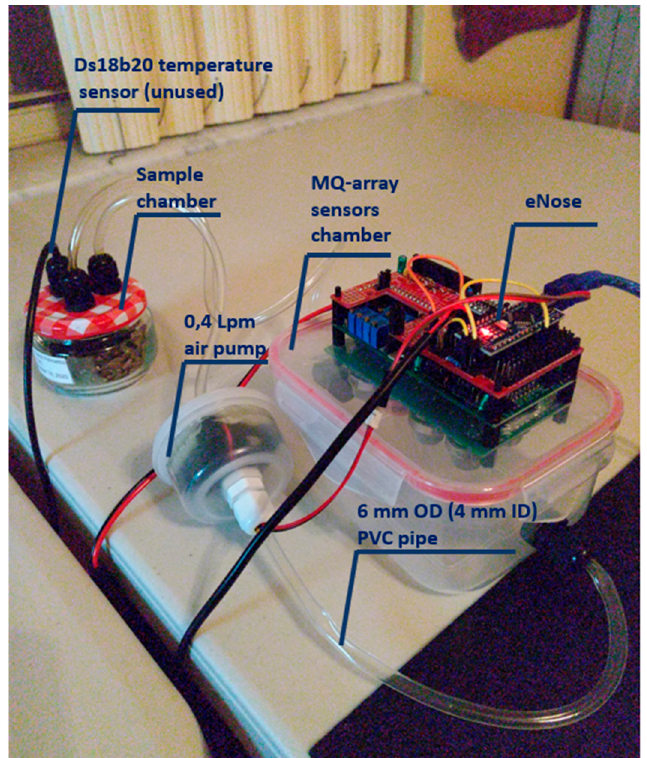
Figure 4. Picture of the electronic nose collecting data. Main parts of the prototype.